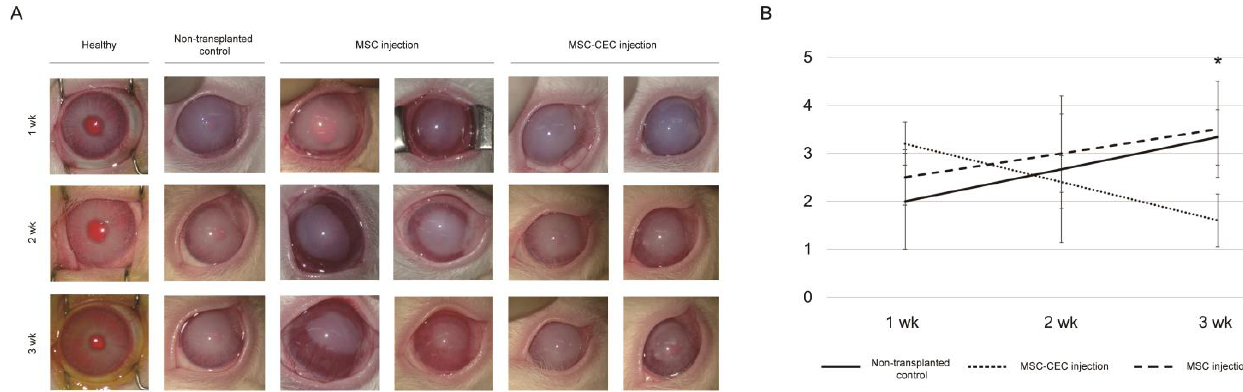
Figure 3. FACS results for MSC-associated surface markers and human CEC-associated markers. ( A ) Results for positively expressed surface markers in human umbilical cord MSCs. ( B ) Results for negatively expressed surface markers in human umbilical cord MSCs. ( C ) Results for marker used to identify CECs.